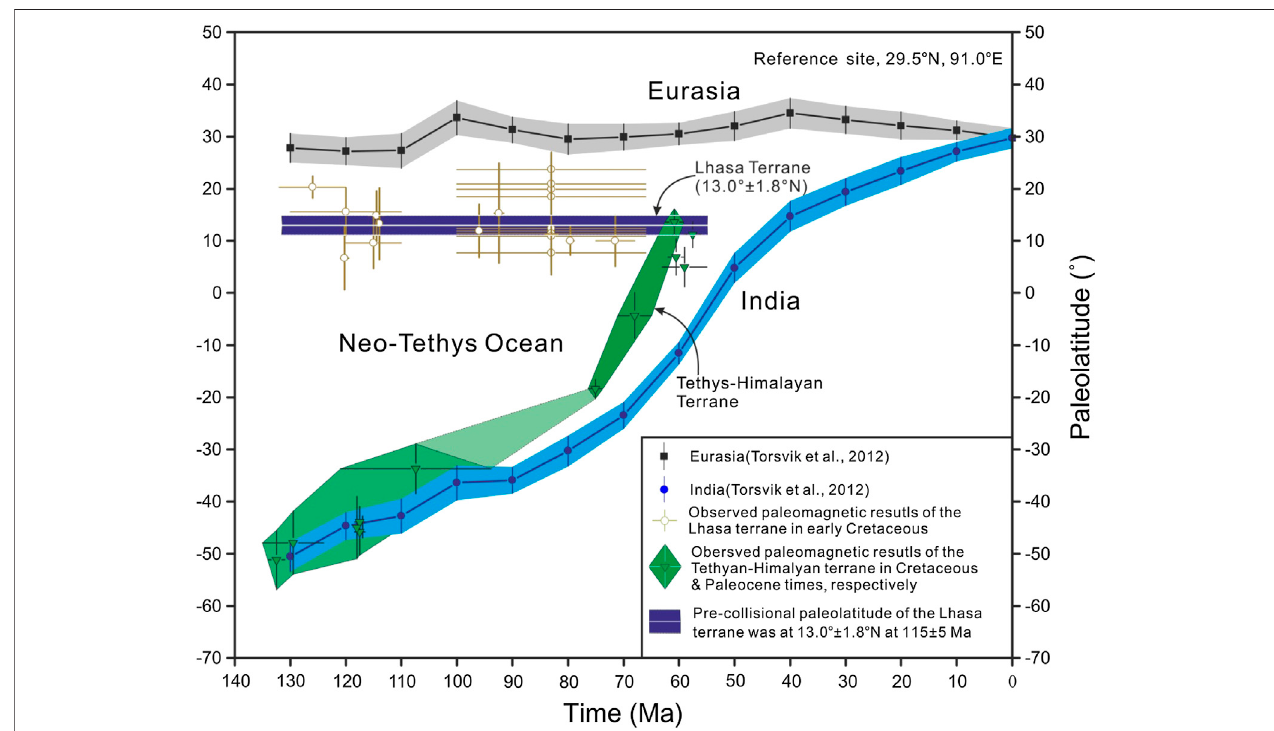
FIGURE10| PaleolatitudesevolutionoftheEurasianandIndiancontinents,theLhasaterrane,andtheTethyanHimalayanterraneasafunctionoftime.Cretaceous paleomagnetic poles of the Lhasa terrane, which were compiled from previously published results, are listed in Table 2 . All paleolatitudes were calculated for the reference site (29.5 ° N, 91.0 ° E). Expected paleolatitudes of the Eurasian and Indian continents are drawn from Torsvik et al. (2008,